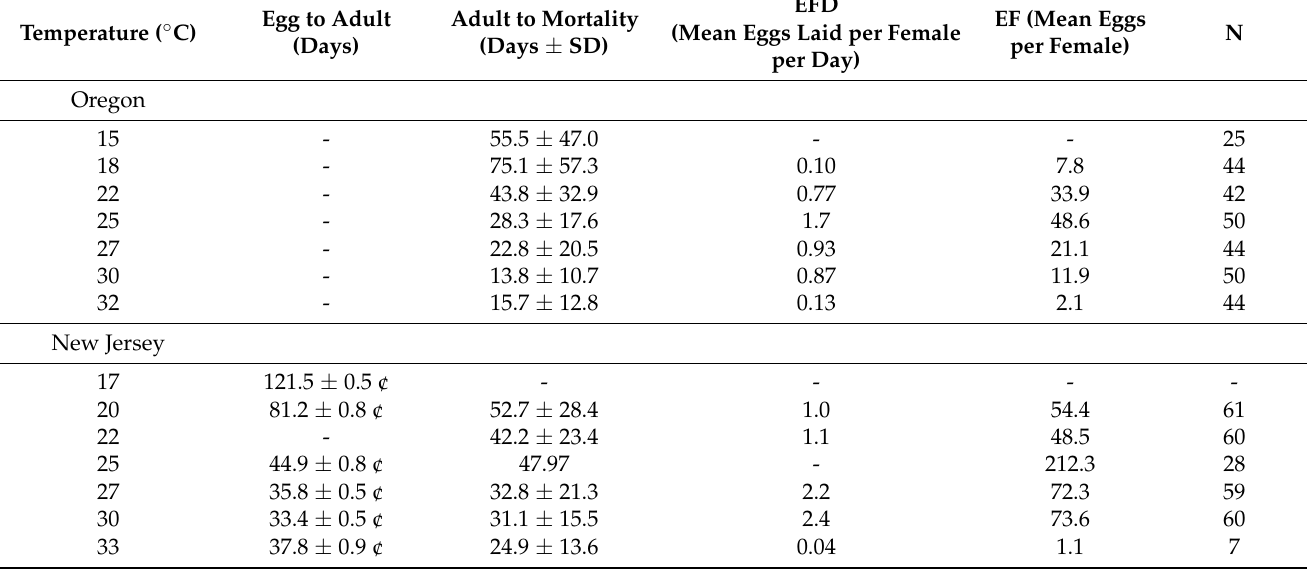
Table 1. Halyomorpha halys adult female survival and reproductive parameters ( ± SD) at con- stant temperatures from Oregon and New Jersey ( ◦ C) (EFD = mean eggs laid per female per day; EF = mean eggs per female; N = number of